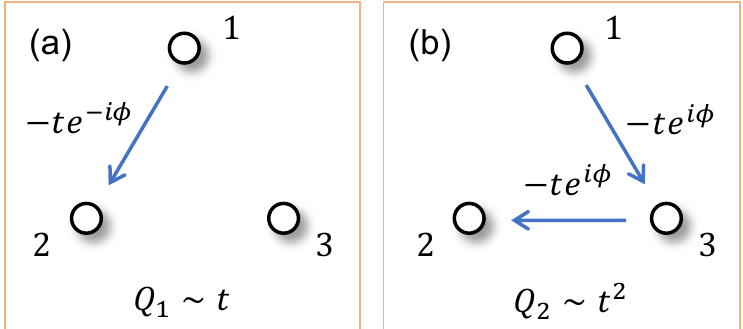
Figure 3: Figure showing the two simplest trajectories allowing propagation from from site 1 to 2; we use t to denote the hopping amplitude J . Panel (a) shows a counter-clockwise trajectory whose probability amplitude is ∝ t , whereas panel (b) shows a clockwise trajectory whose amplitude is ∝ t 2 . The interference between these trajectories can be controlled by varying both the phase φ associated with the synthetic flux piercing the ring, the hopping amplitude t and the damping rate κ of mode 3 (which shows up in the energy denominator associated with the amplitude of process Q 2